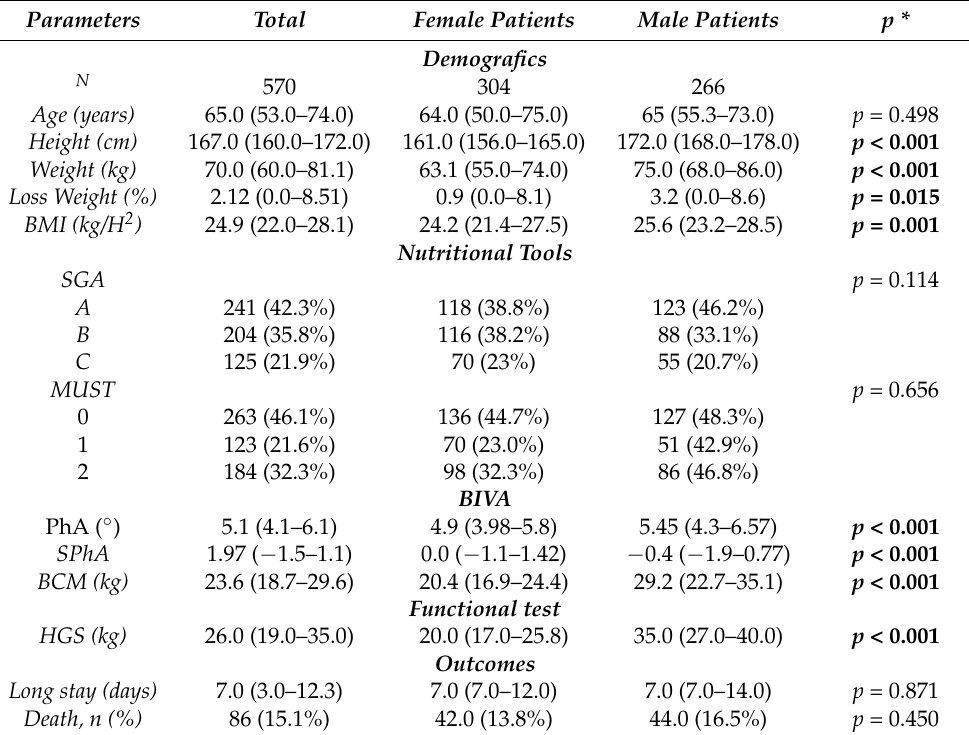
Table 1. Demographic parameters, nutritional tools, BIVA, Functional test and Outcomes results by